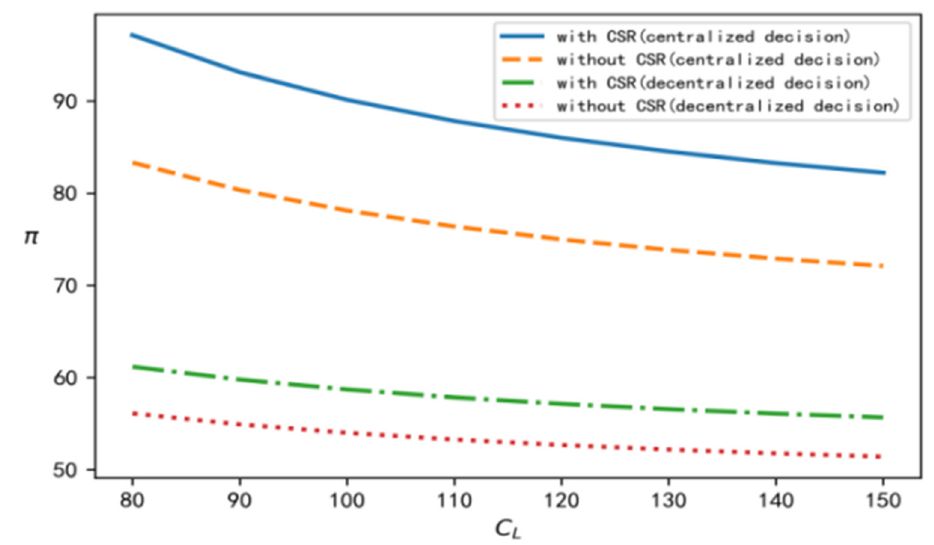
Figure 4. Change trend of the overall profits of closed-loop supply chain.